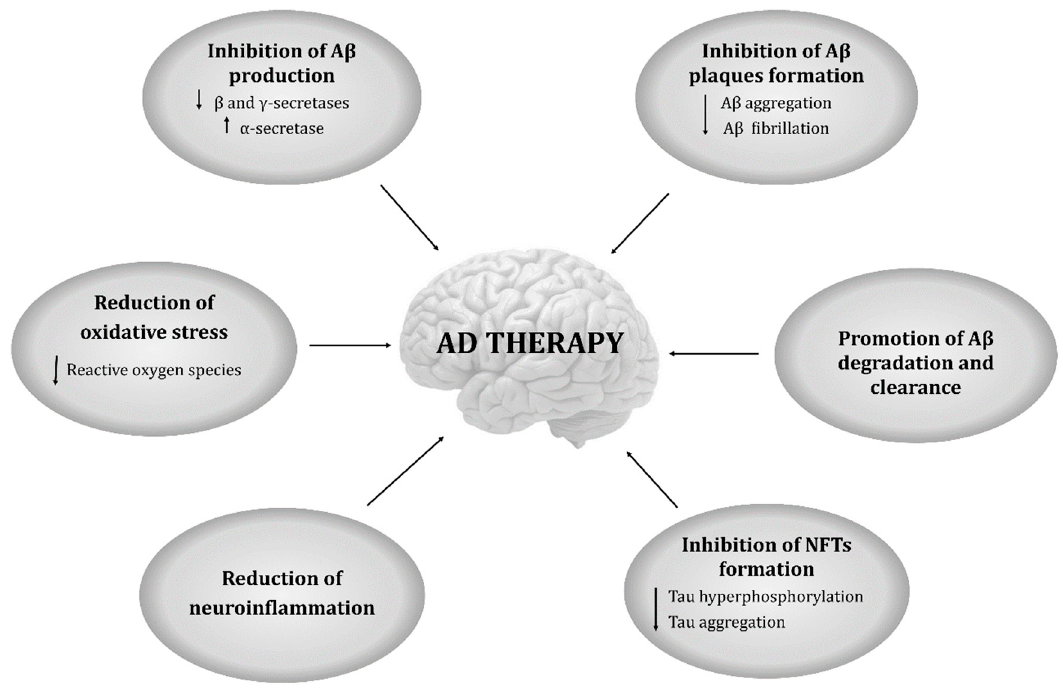
Figure 1. Schematic representation of the several mechanisms associated with Alzheimer’s Disease (AD) therapy. Down and up oriented arrows indicate the decrease and the increase of the fenomena, respectively.